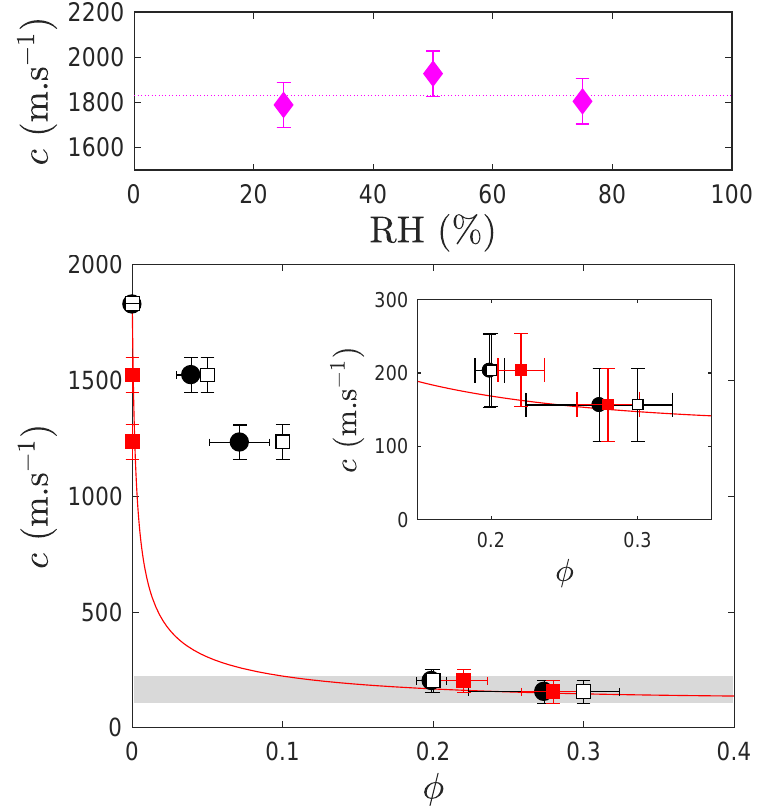
Figure 6. Top: sound speed of a bare polymer ( φ = 0) as a function of relative humidity (RH). Main: sound speed a function of the porosity in the polymer. The open symbols refer to as the nominal volume fraction of calcite in the initial formulation; the black solid symbols show the porosity estimated from image analysis; the red solid symbols show the porosity estimated from density measurements. The gray region highlights the high porosity zone where all measurements match. The solid line is derived from the theory of effective media given by Equation (2) with no fitting parameter. Insert: close-up at high porosity.